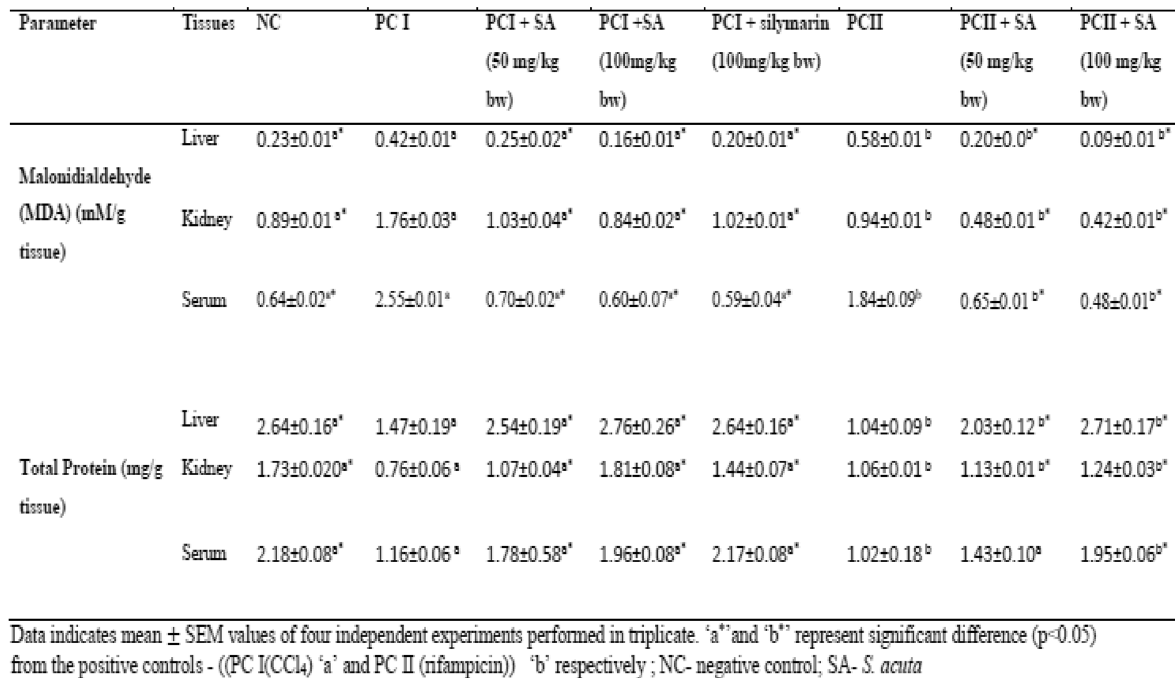
Table 6 Effect of S. acuta extract on lipid peroxidation in rats exposed to CCI 4 and rifampicin